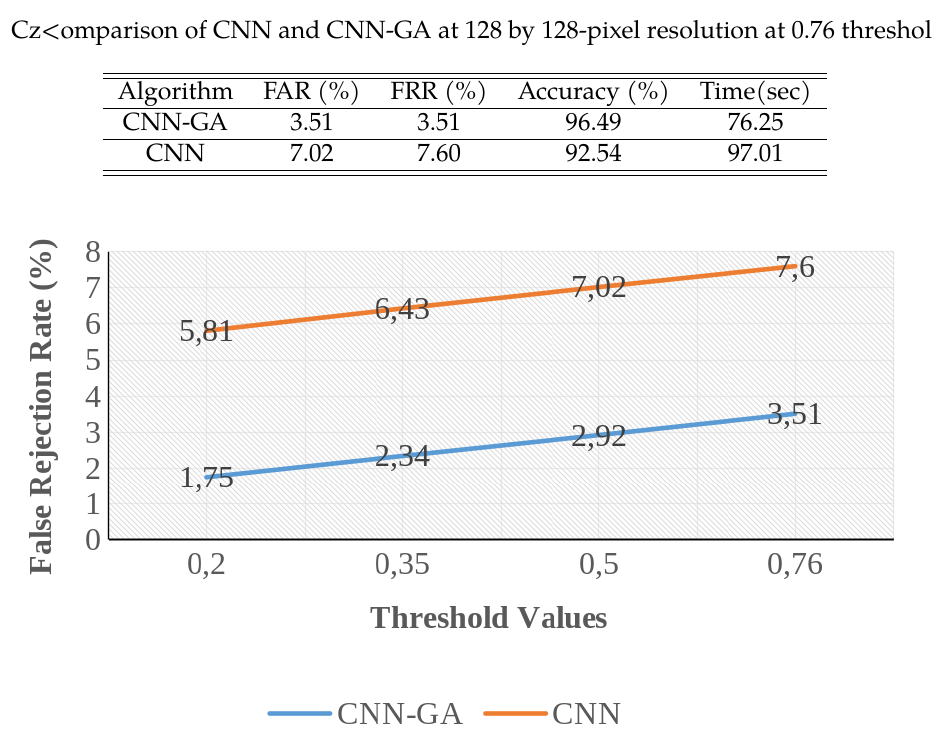
Figure 1: Graph of False Rejection